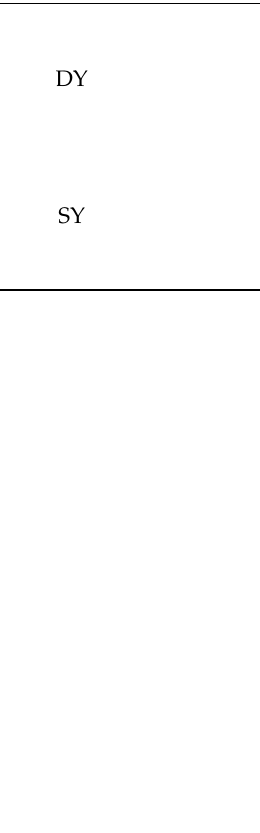
Table 2. Effects of Se fertilizer application on the dry weight of maize at locations DY and SY.